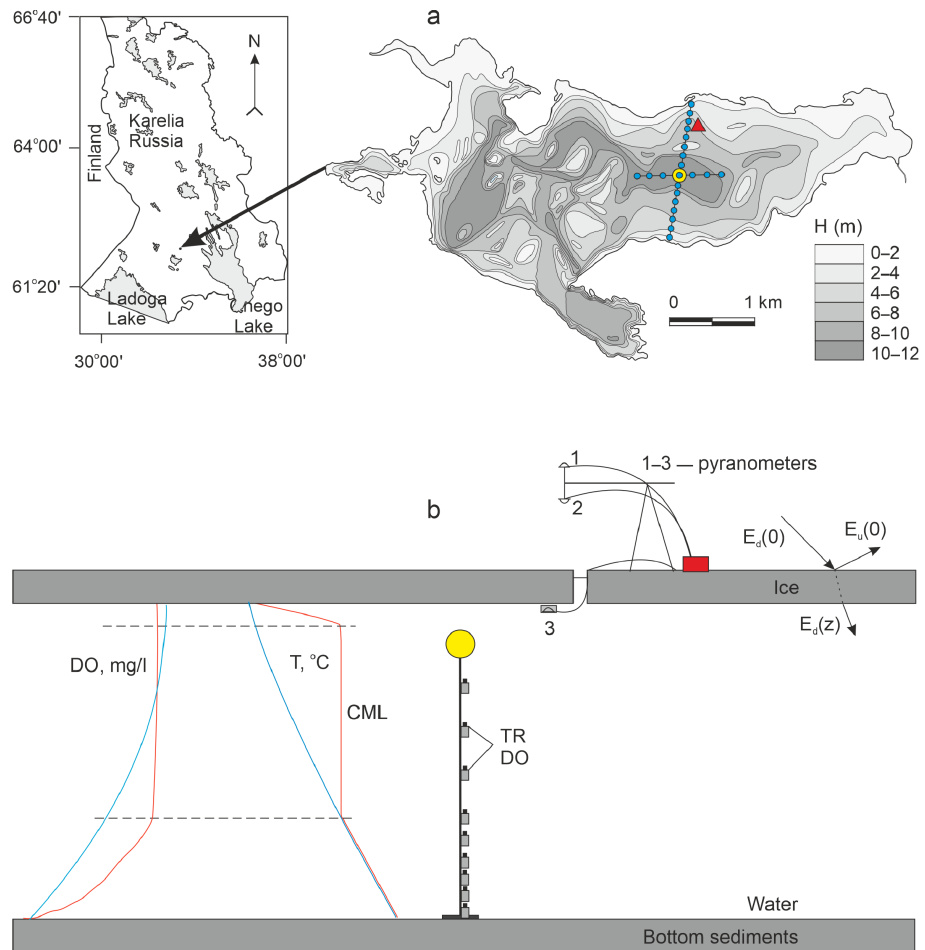
Figure 1. ( a ) Geographic location (black arrow) and bathymetry map of Lake Vendyurskoe, and locations of measurement Scheme 1995. ( b ) Setup of the observation site, sketch of the thermal and DO structures during spring under-ice convection and of radiative transfer through the ice. Blue and red lines indicate vertical DO and temperature profiles in winter and during radiatively driven convection, respectively. CML—convectively mixed layer. E d (0) and E d (z)—downwelling planar irradiances at the ice surface and under the ice, E u (0)—upwelling irradiances at the ice surface.